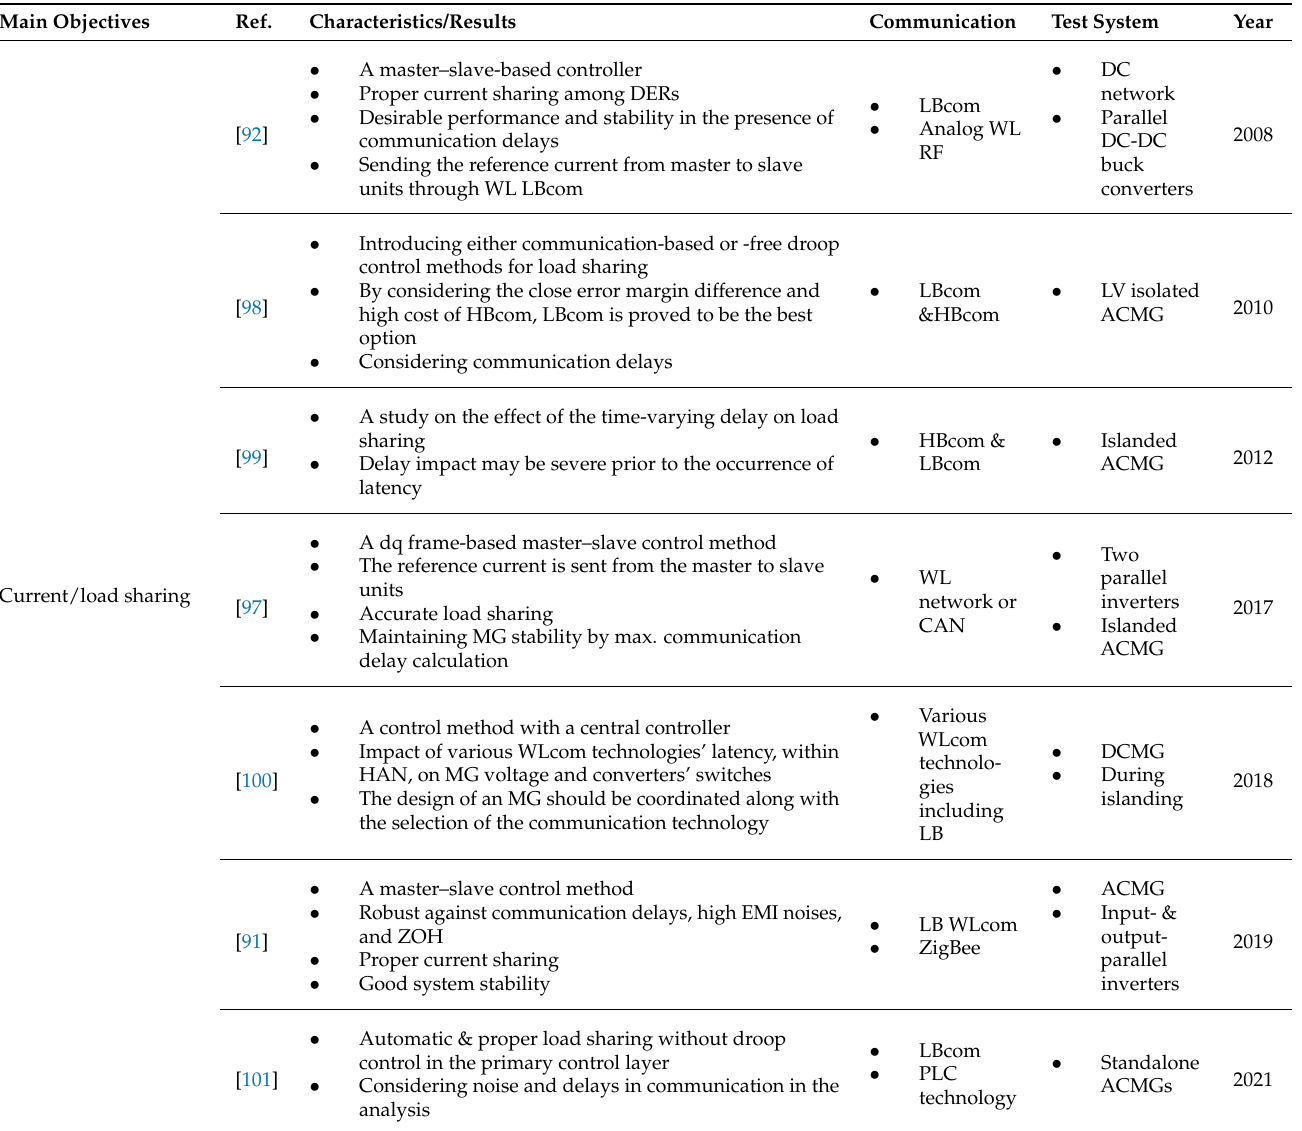
Table 13. Summarizing and categorizing important LBcom-based control methods in the primary control